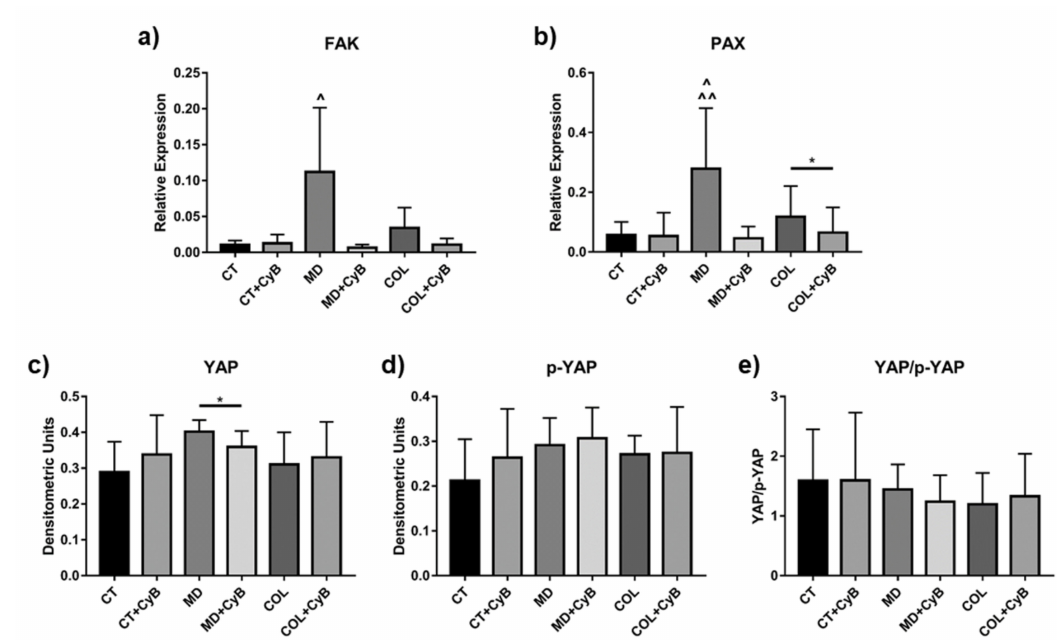
Figure 10. Bar graphs showing FAK ( a ) and PAX ( b ) mRNA levels after normalization on GAPDH gene expression. Data are means ± SD for at least two independent experiments. For YAP expression, the active-form YAP ( c ), the inactive phosphorylated form ( d ) and the YAP / p-YAP ratio ( e ) were assessed by Western blot and represented by the histograms showing mean ± SD for at least two independent experiments for the considered experimental groups. * p < 0.05 for t -test; ˆ p < 0.05 vs. CT, CT + CyB, MD + CyB, COL + CyB; ˆˆ p < 0.01 vs. MD + CyB and COL + CyB using ANOVA.